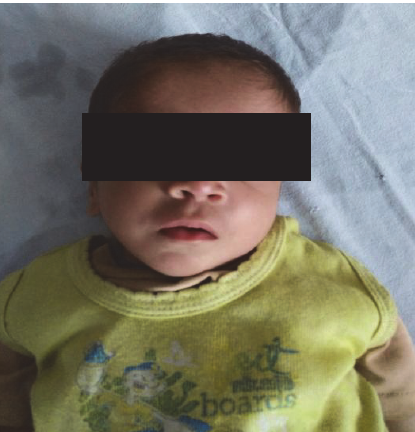
Figure 3: X-rays left hand: absent radius with absent thumb